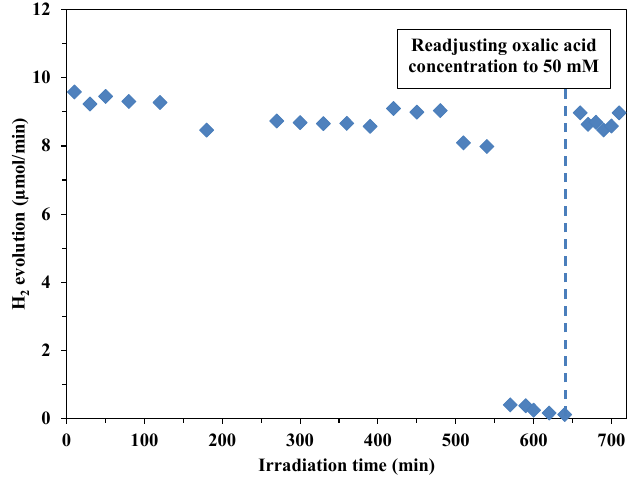
Figure 8. Long-term irradiation and H 2 evolution rates on Au-TiO 2 photocatalyst in a suspension containing oxalic acid ( c OA, initial = 50